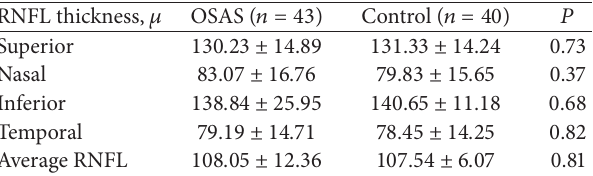
Table 2: The mean retinal nerve fiber layer (RNFL) thickness ( 𝜇 ) values in the